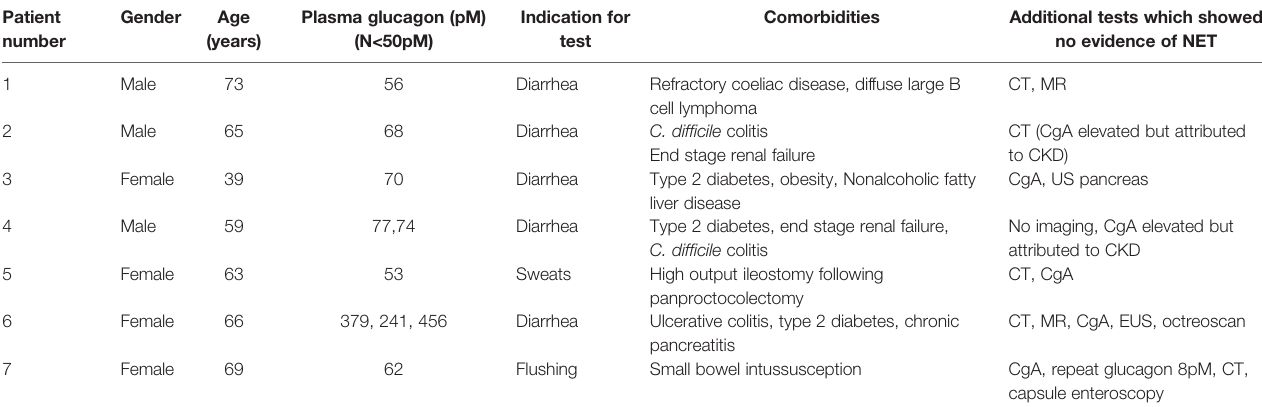
TABLE 2 | Clinical details of patients with raised plasma glucagon